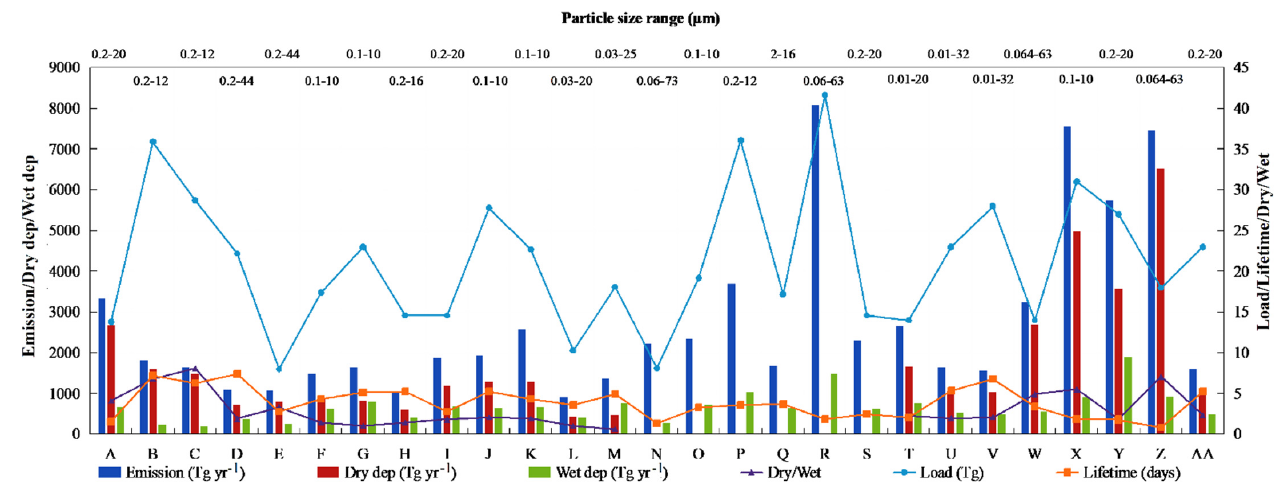
Figure 4. Global and annual mean dust budget according to several dust models. A: Takemura et